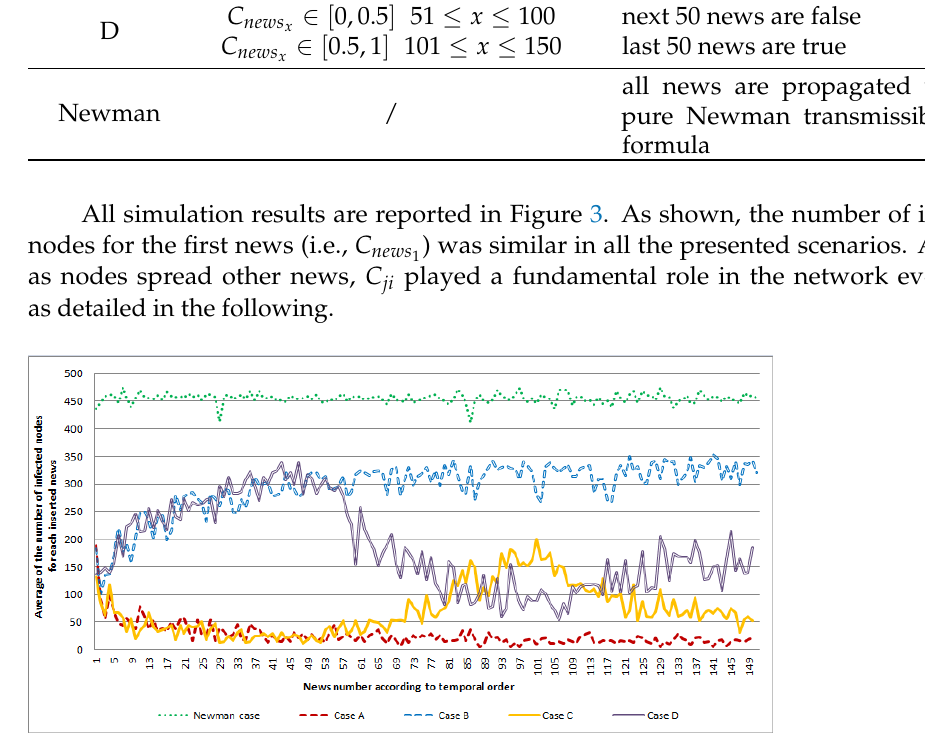
Figure 3. Temporal evolution of the average number of infected nodes in different